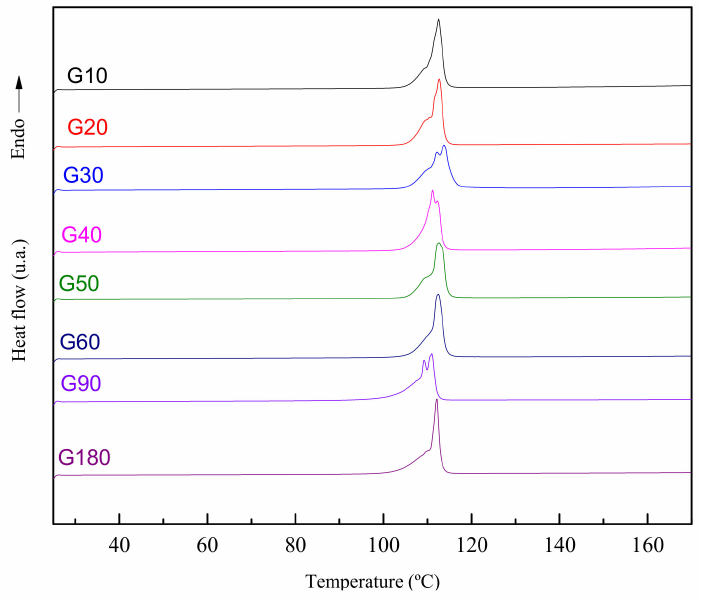
Figure 2. DSC thermograms corresponding to the products obtained at different reaction